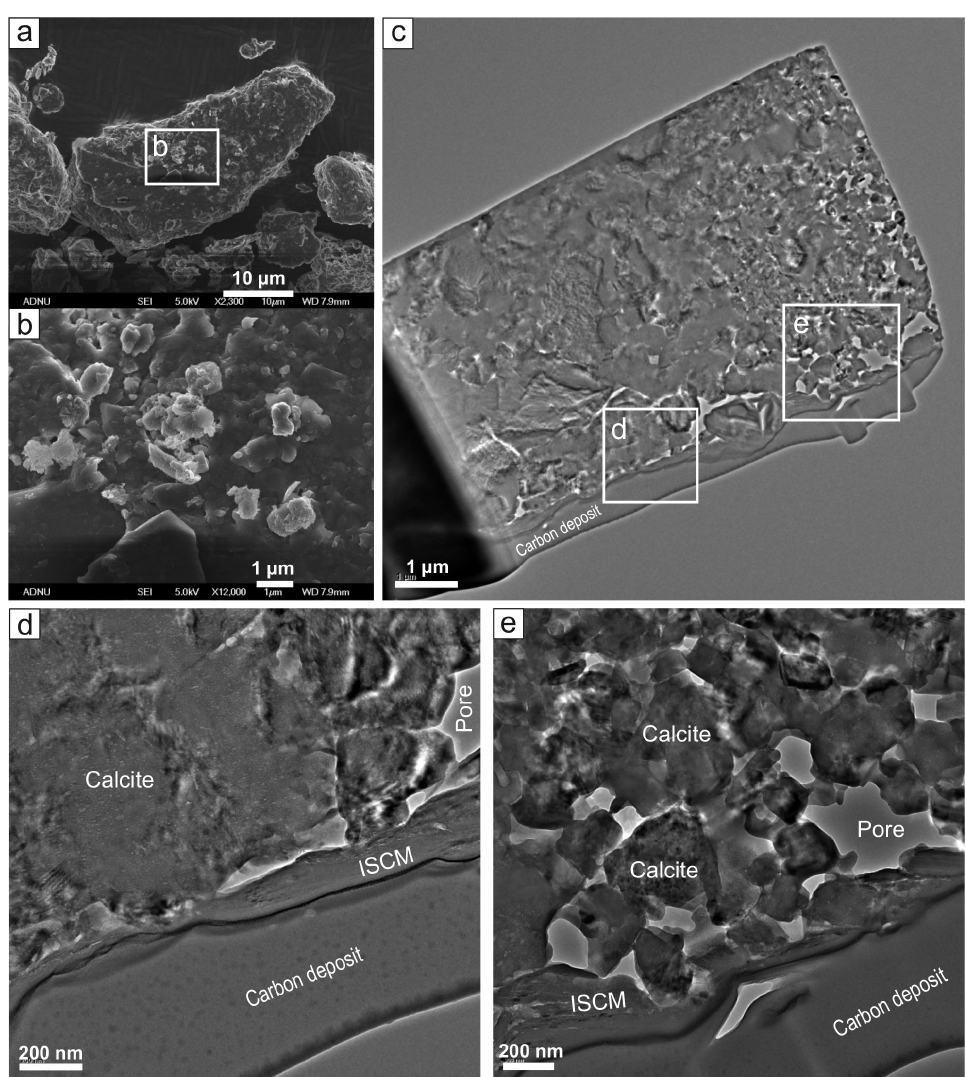
Figure 8. Calcite-rich dust particle from 2012 Asian dust. (a) SEM image of the dust particle. (b) SEM image of the particle surface magnified from the box in (a) . (c) Overall TEM image of the FIB slice prepared from the particle in (a) . (d, e) TEM images magnified from the box in (c)